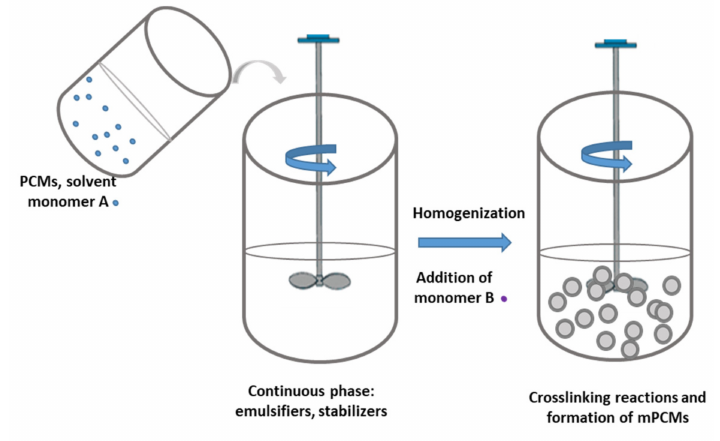
Figure 7. Schematic representation of the microencapsulation process by interfacial